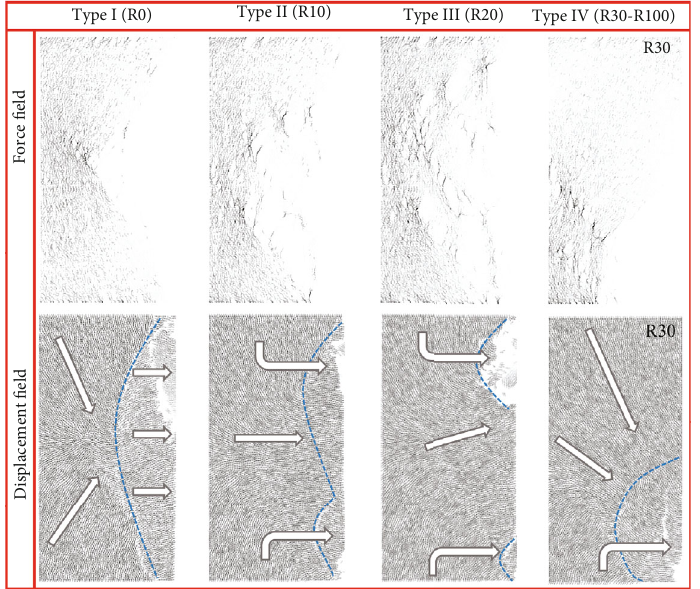
Figure 20: Four types of force and displacement fi eld corresponding to di ff erent